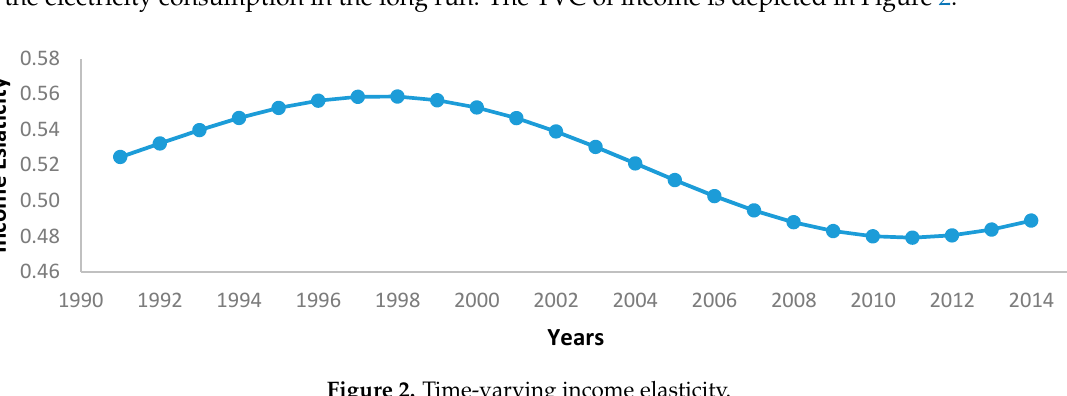
Figure 2. Time-varying income elasticity.